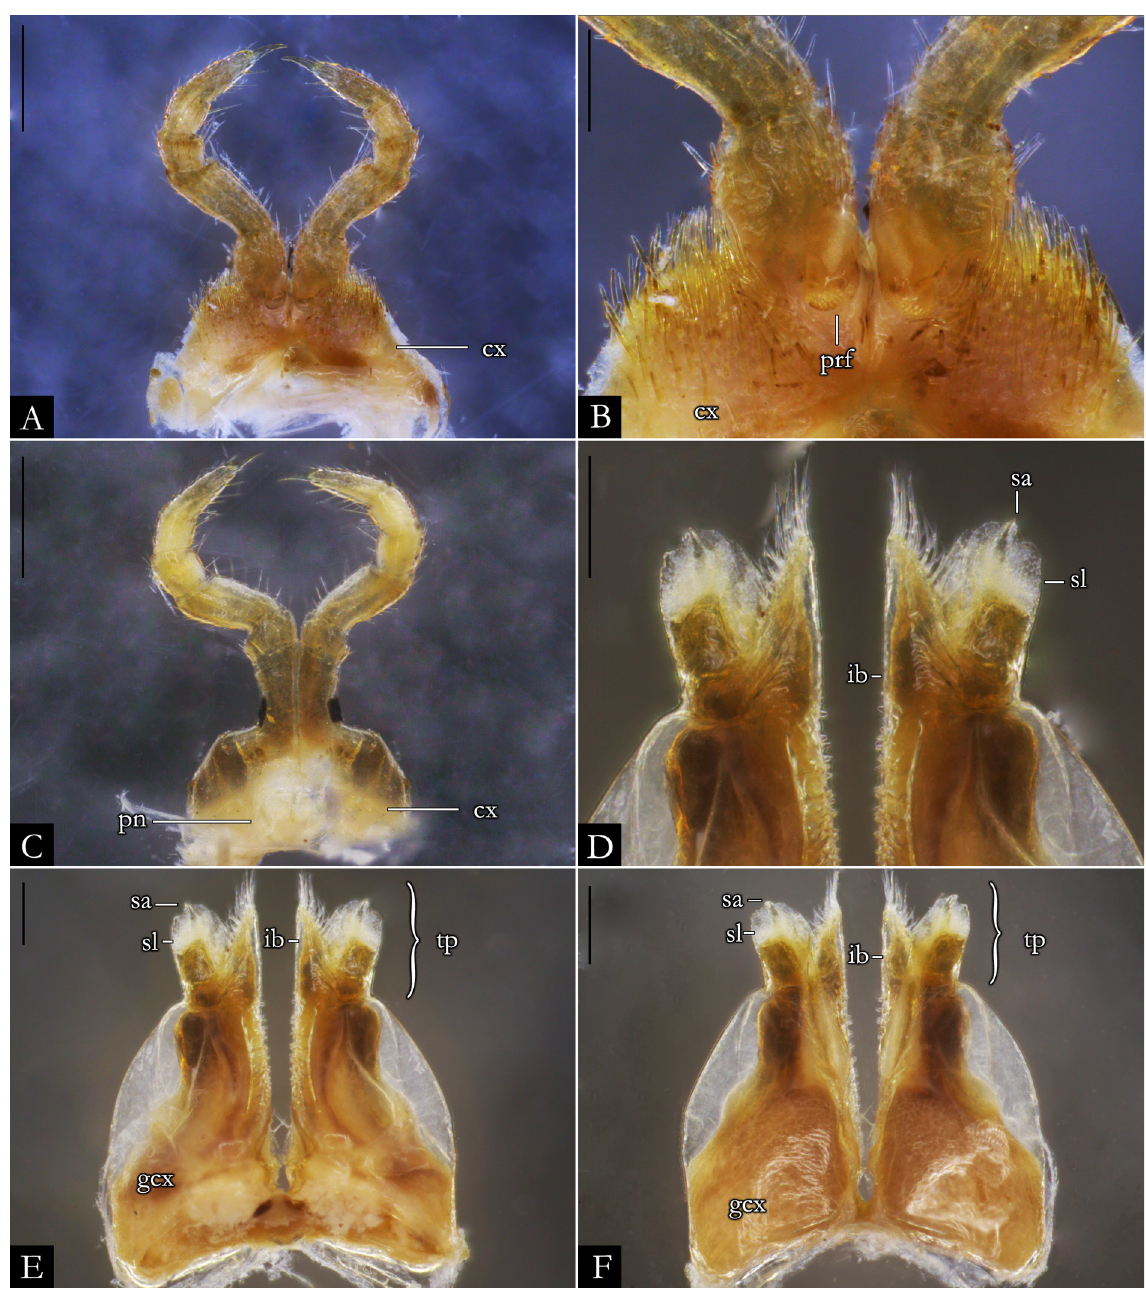
Fig. 104. Pseudonannolene parvula Silvestri, 1902, ♂ (IBSP 7630). A . First leg-pair. B . Detail of prefemur. C . Second leg-pair. D . Detail of telopodites, in anal view. E . Gonopods, in anal view. F . Gonopods, in oral view. Abbreviations: see Material and methods. Scale bars: A, C, E–F = 0.5 mm; B, D = 0.2